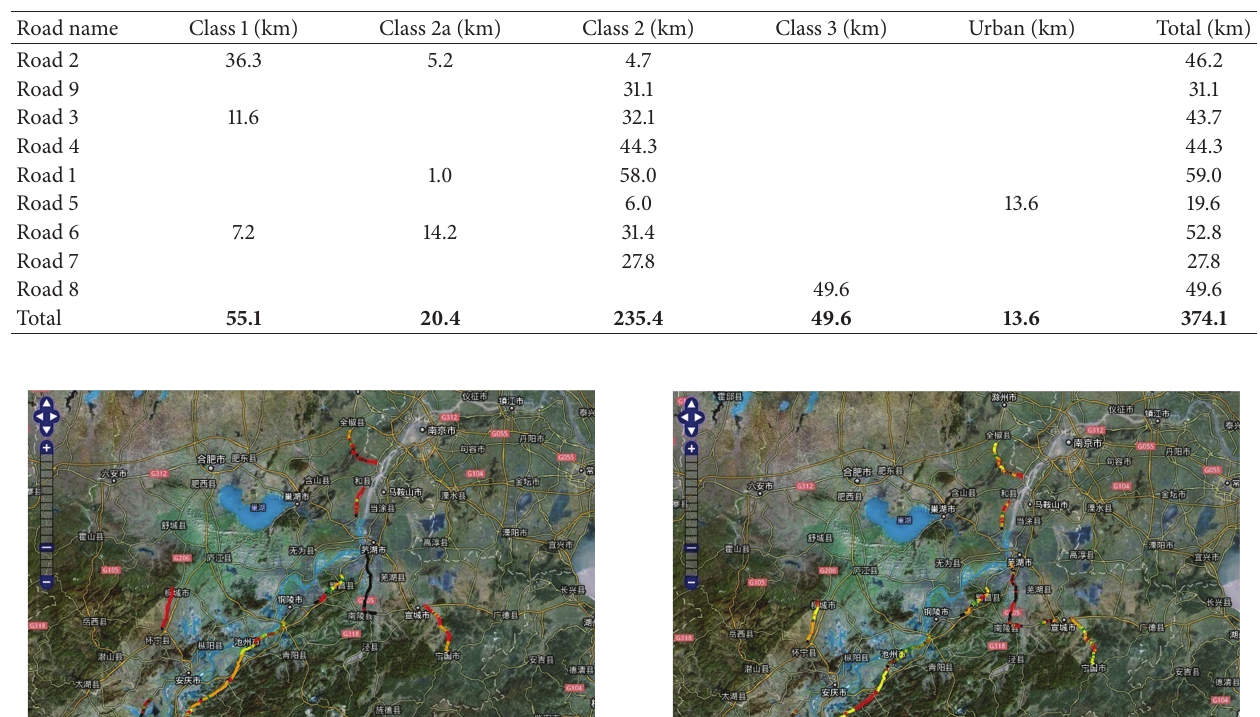
Table 3: Network surveyed.